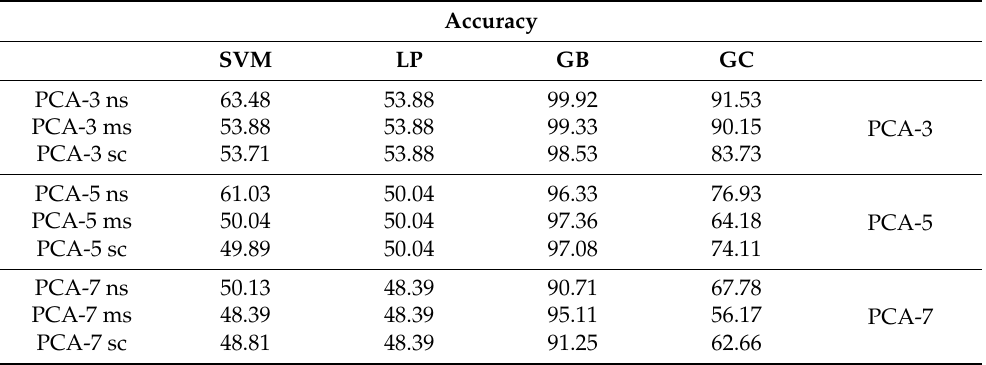
Table 5. The classification accuracy for CyanoHAB HSI using PCA 3, 5, and 7 bands, with the three types of scaling using the four machines for a 1000 pixels batch size.